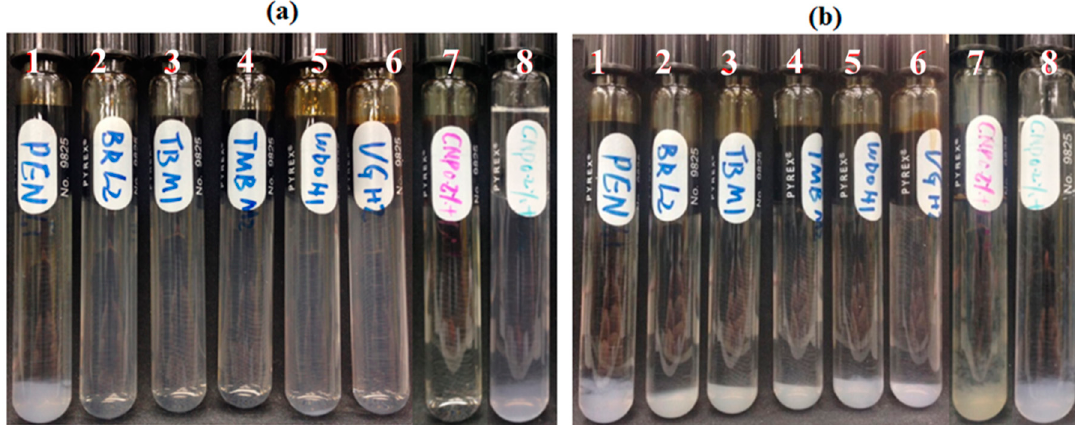
Figure 14 . ANP suspensions stability screening with different type of oils: ( a ), Day 1; ( b ), Day 3; (1: